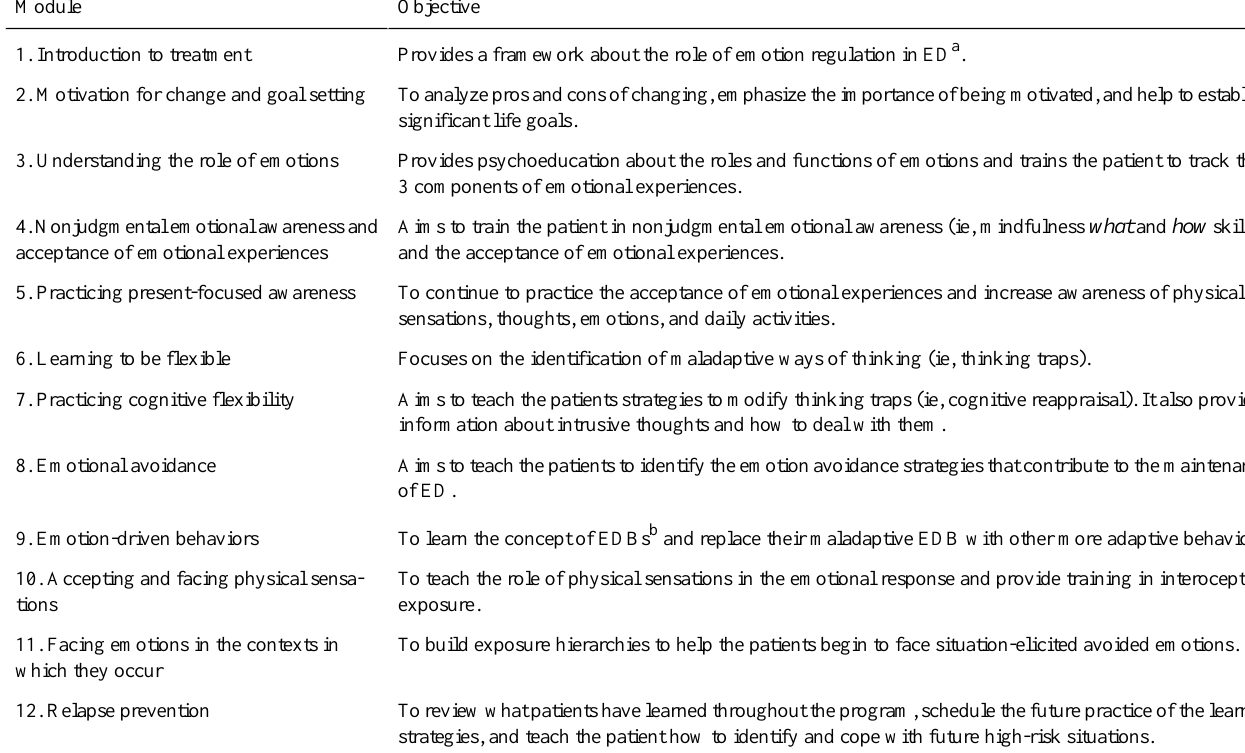
Table 1. Treatment modules and their